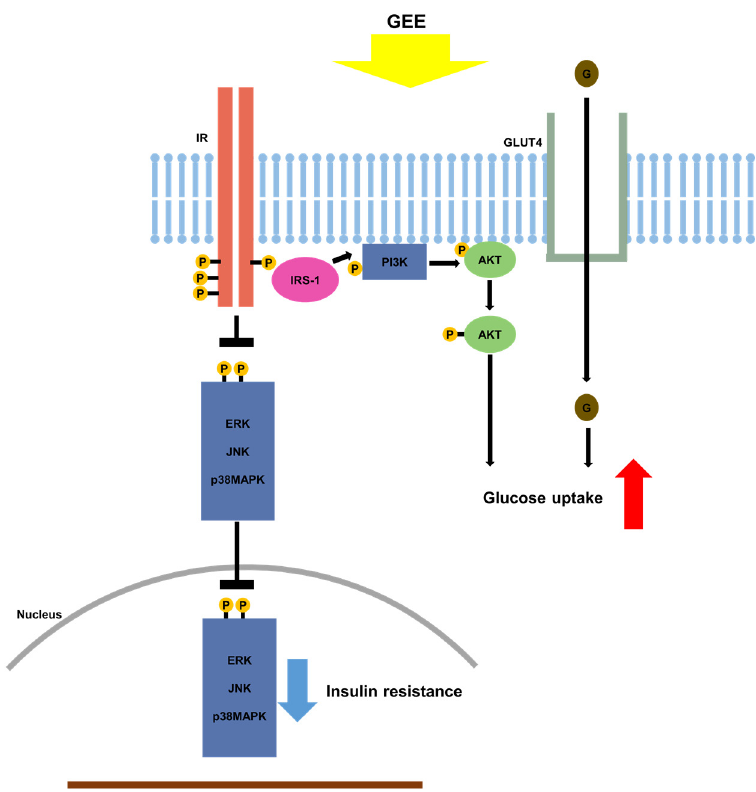
Figure 6. Proposed mechanism whereby GEE ameliorates type 2 diabetes through the regulation of MAPK and PI3K/Akt signaling. Gelidium elegans extract (GEE) stimulates glucose uptake and thus should ameliorate the clinical signs of diabetes, through activation of the phosphatidylinositol-3 kinase (p-PI3K)/protein kinase B (Akt) signaling pathway and suppression of mitogen-activated protein kinase (MAPK) signaling pathways. → indicates stimulation; ⊥ , inhibition; IR, insulin receptor; GLUT4, glucose transporter type 4; ERK, p44/42 MAPK; JNK; c-Jun N-terminal kinases.